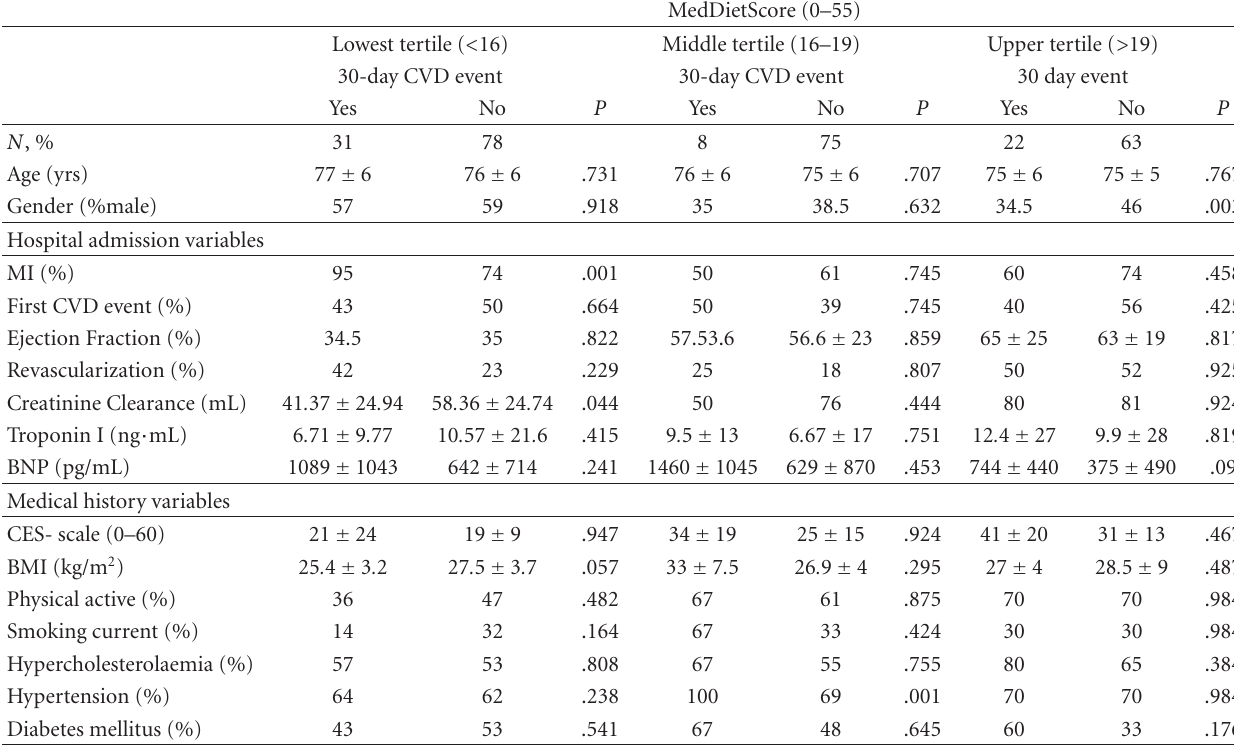
Table 2: Clinical, biochemical, and lifestyle characteristics of ACS elderly patients ( n = 277), according to the development of 30-day CVD events and their dietary